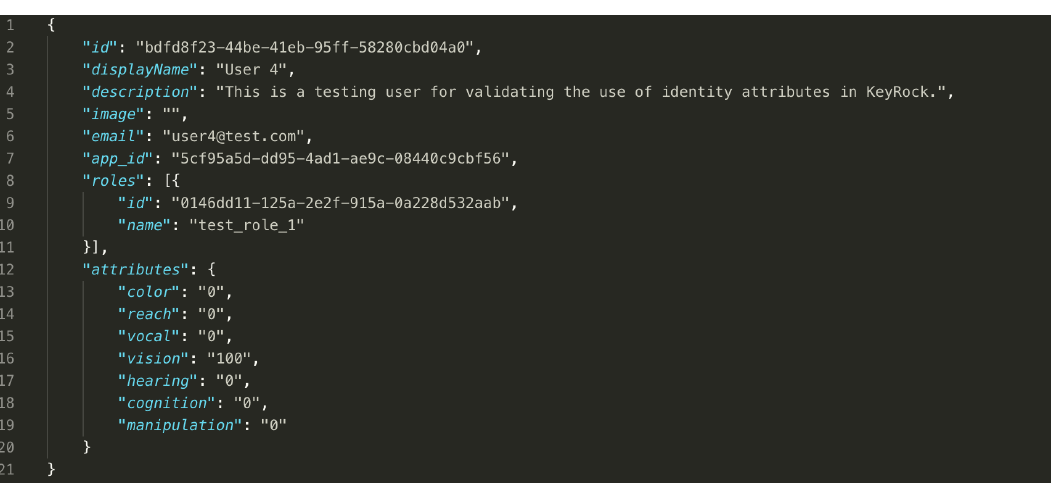
Figure 6. User profile returned by Keyrock.